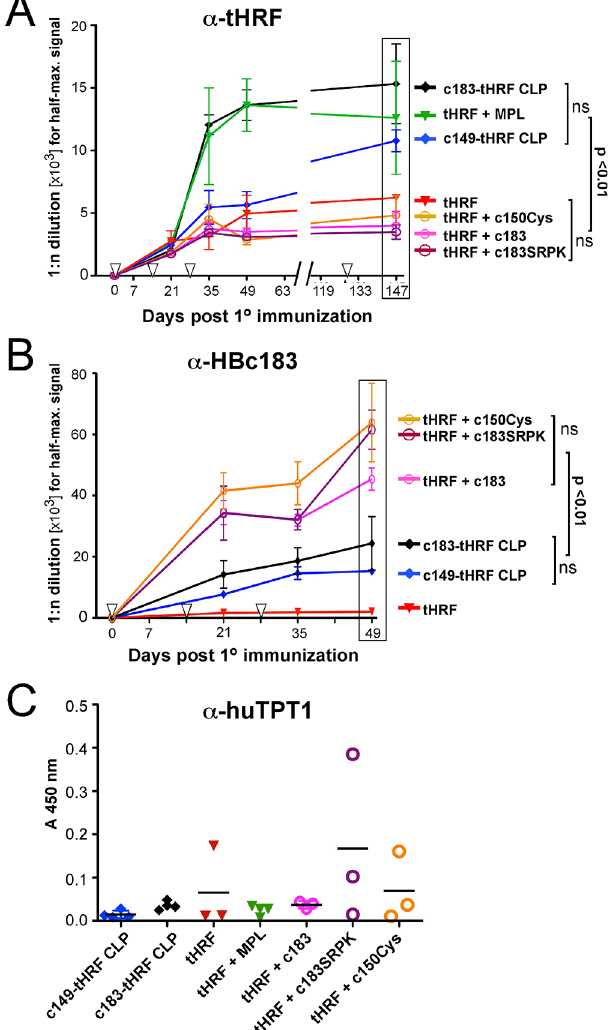
Fig 4. Characterization of antibodies in mouse immune sera (IS) after vaccination with different tHRF antigen preparations. Groups of three to four mice each were vaccinated at days 0, 14, 28 and 126 (downward pointing open arrowheads) with the indicated vaccine formulations. Two-fold serial dilutions of blood samples from individual mice taken at the indicated timepoints post first injection were analyzed by ELISA. The means ± SEM are plotted against time. Significance of differences between groups was assessed for the boxed time-points. (A) Anti-tHRF response. Dose-response curves against plate- immobilized tHRF from 1:1,000 to 1:128,000 dilutions of the individual IS from each group were used to derive the dilution giving the half-maximal ELISA reading, using Graphpad Prism software. Note that HBc CLPs administered in trans did not increase the anti-tHRF response compared to tHRF alone. (B) Anti- HBc183 response. Data were obtained as in (A), except HBc183 CLPs was used as immobilized test antigen. Note the high-titered anti-HBc response in all IS derived from co-administered HBc CLPs. (C) Anti- TPT1 response. Mouse IS from day 49 p.i. were analyzed using recombinant human TPT1 as ELISA test antigen. Due to substantial inter-animal variation, a scatter blot for the individual animals from each group is shown; the horizontal bars indicate the mean values. Note that at least one mouse from the groups immunized with tHRF alone, or tHRF plus HBc183 or HBc150Cys CLPs developed a detectable anti-TPT1